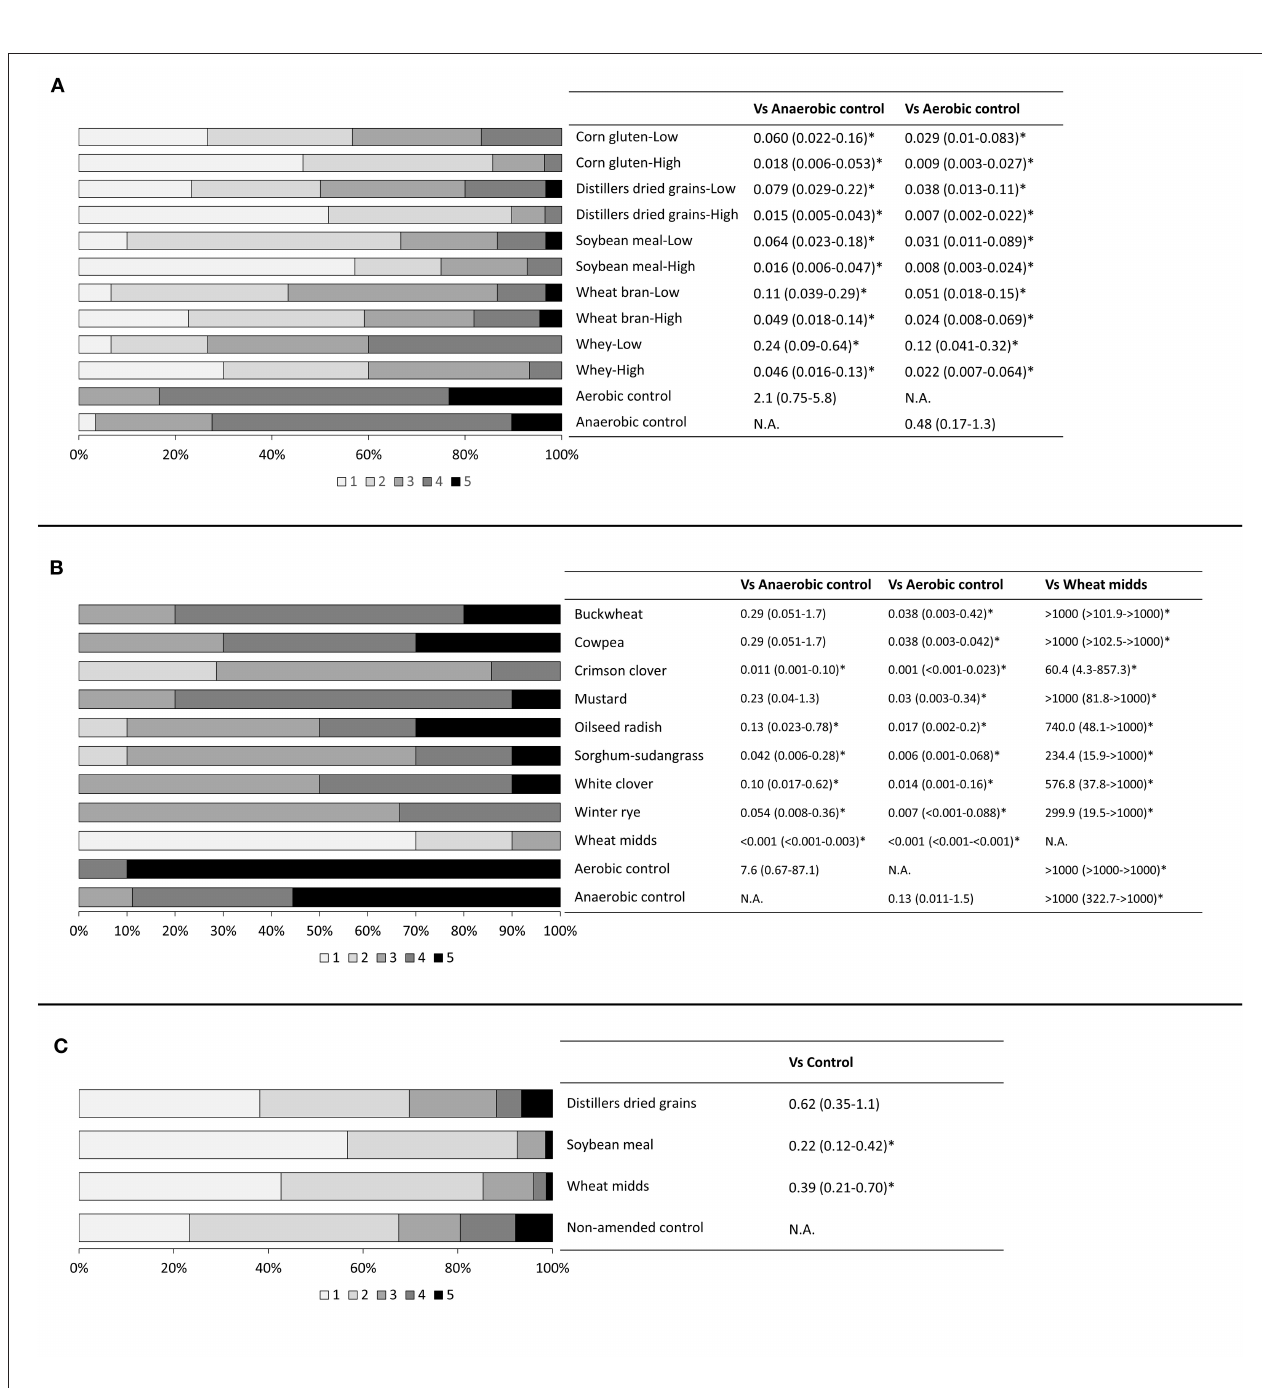
FIGURE 2 | Taproot rot severity of bioassay plants grown in soils subjected to anaerobic soil disinfestation (ASD) using (A) various agricultural byproduct carbon sources, (B) cover crop carbon sources, or (C) a subset of ASD carbon sources evaluated in on-farm trials. Roots were rated on a 1–5 scale with 1: taproot healthy, 2: one to two small lesions or slight discoloration on taproot, 3: multiple lesions covering < 50% of the taproot, 4: multiple lesions covering more than 50% of the taproot, 5: taproot completely rotten or missing. Proportional odds ratios are shown, along with confidence intervals, with a star indicating significance at P < 0.05. Odds ratios of < 1 indicate that an ASD treatment was associated with lower taproot rot ratings compared to a control, while odds ratios of > 1 indicate that an ASD treatment was associated with higher taproot rot ratings compared to a